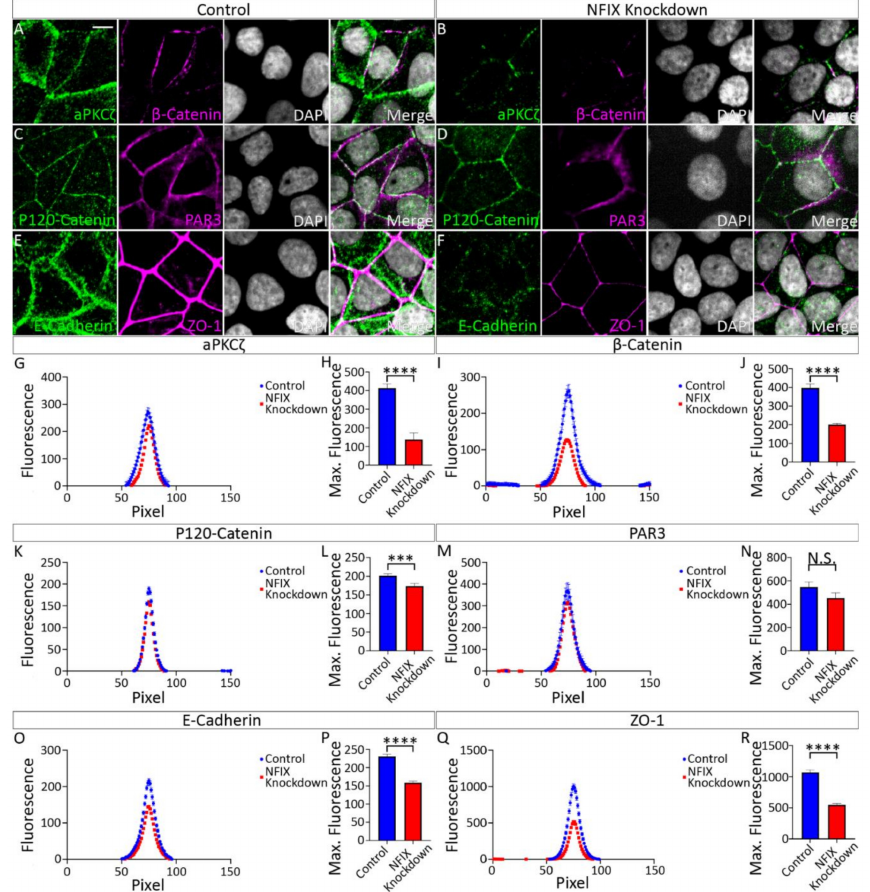
Figure 5. MCF7 cells treated with NFIX knockdown lentivirus demonstrate reduced localisation of adhesion proteins. ( A , B ) Images depicting MCF7 cells treated with scramble RNA lentivirus (scram- ble, A ) or NFIX shRNA lentivirus (NFIX KD, B ) and stained with antibodies against tight junction marker aPKC ζ (green), adherens junction marker β -Catenin (purple) and nuclear marker DAPI (grey) displayed as separate panels or merged. ( C , D ) Images depicting NFIX KD ( C ) and scramble ( D ) cells stained with antibodies against adherens junction marker P120-Catenin (green), tight junction marker PAR3 (purple) and nuclear marker DAPI (grey) displayed as separate panels or merged ( E , F ) Images depicting NFIX KD ( E ) and scramble ( F ) cells stained with antibodies against adherens junction marker E-Cadherin (green), tight junction marker ZO-1 (purple) and nuclear marker DAPI (grey) displayed as separate panels or merged. ( G , I , K , M , O , Q ) Average fluorescent intensity across the cell junction was plotted for line scanning measurements of aPKC ζ ( G ), β -Catenin ( I ), P120-Catenin ( K ), PAR3 ( M ), E-Cadherin ( O ) and ZO-1 ( Q ) for NFIX KD cells and controls. Tight junction proteins aPKC ζ and ZO-1 demonstrated reduced fluorescent intensity peaks in NFIX KD cells compared to controls. Tight junction protein PAR3 demonstrated no changes between treatment conditions. Adherens junction proteins β -Catenin, P120-Catenin and E-Cadherin demonstrated reduced peak fluorescence in NFIX KD treated cells compared to controls. ( H , J , L , N , P , R ) Maximum fluorescent intensity across the junction of aPKC ζ ( H ), β -Catenin ( J ), P120-Catenin ( L ), PAR3 ( N ), E-Cadherin ( P ) and ZO-1 ( R ) for NFIX KD cells and controls. Tight junction proteins aPKC ζ and ZO-1 demonstrate significant reduction in the maximum fluorescence of NFIX KD cells compared to controls. Tight junction protein PAR3 demonstrates no significant difference between treatment conditions. Ad- herens junctions proteins β -Catenin, P120-Catenin and E-Cadherin demonstrate significantly reduced maximum fluorescent intensity in NFIX KD cells compared to controls. *** p < 0.001, **** p < 0.0001, N.S. (not significant), two-tailed t -test. Graphs depict mean ± s.e.m. from three samples per genotype with an n of 150 junctions. Scale bar ( A ) represents 10 µ